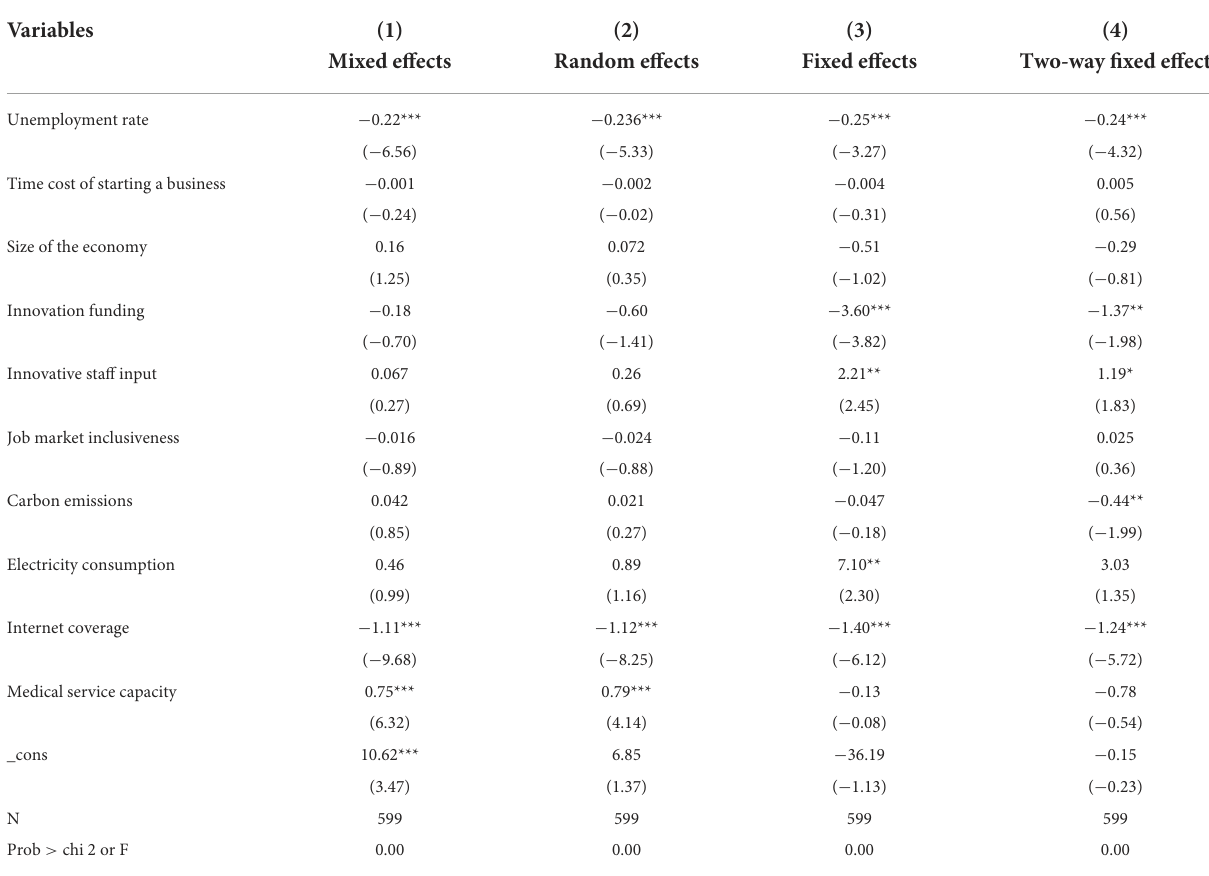
TABLE 2 Impact of unemployment on economic